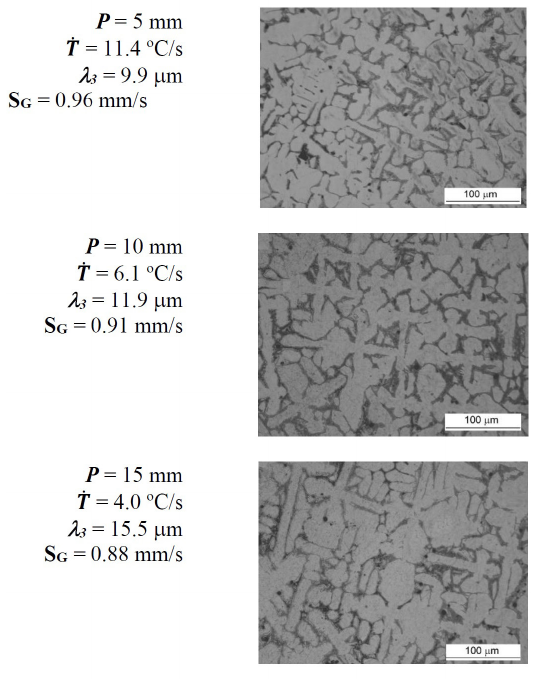
Figure 7. Photomicrographs of specimen taken from cross section of casting.